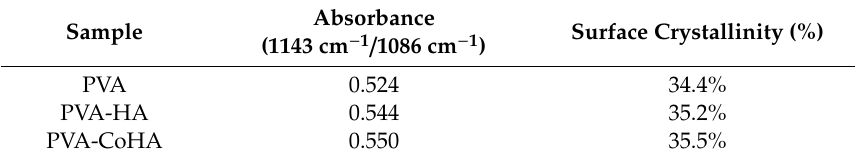
Table 1. The relative intensities of 1143 cm − 1 and 1086 cm − 1 peak in ATR-FTIR spectra of PVA and PVA / CoHA